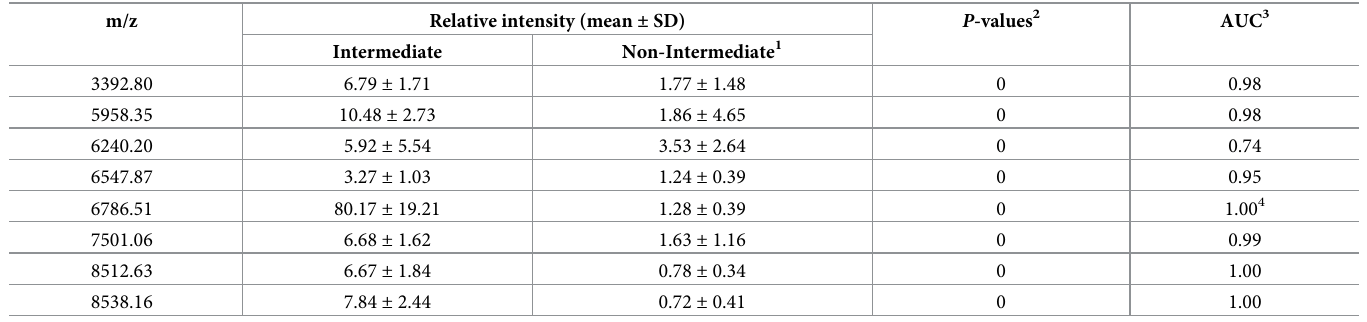
Table 6. Peak statistics of 8 discriminating peaks for intermediate leptospires included in the GA